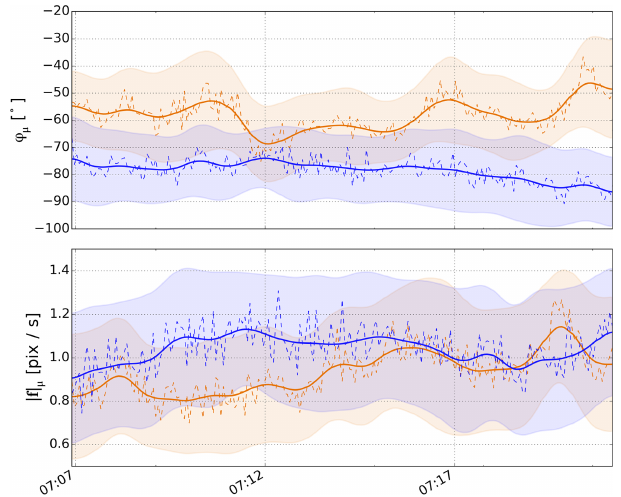
Figure 5. Time series of retrieved PDV parameters ϕ µ and | f | µ (dashed lines) for the two Etna PCS lines (same colours; cf. Fig. 1) and corresponding values after applying interpolation and smooth- ing (solid lines). The expectation intervals I ϕ and I | f | are plotted as shaded